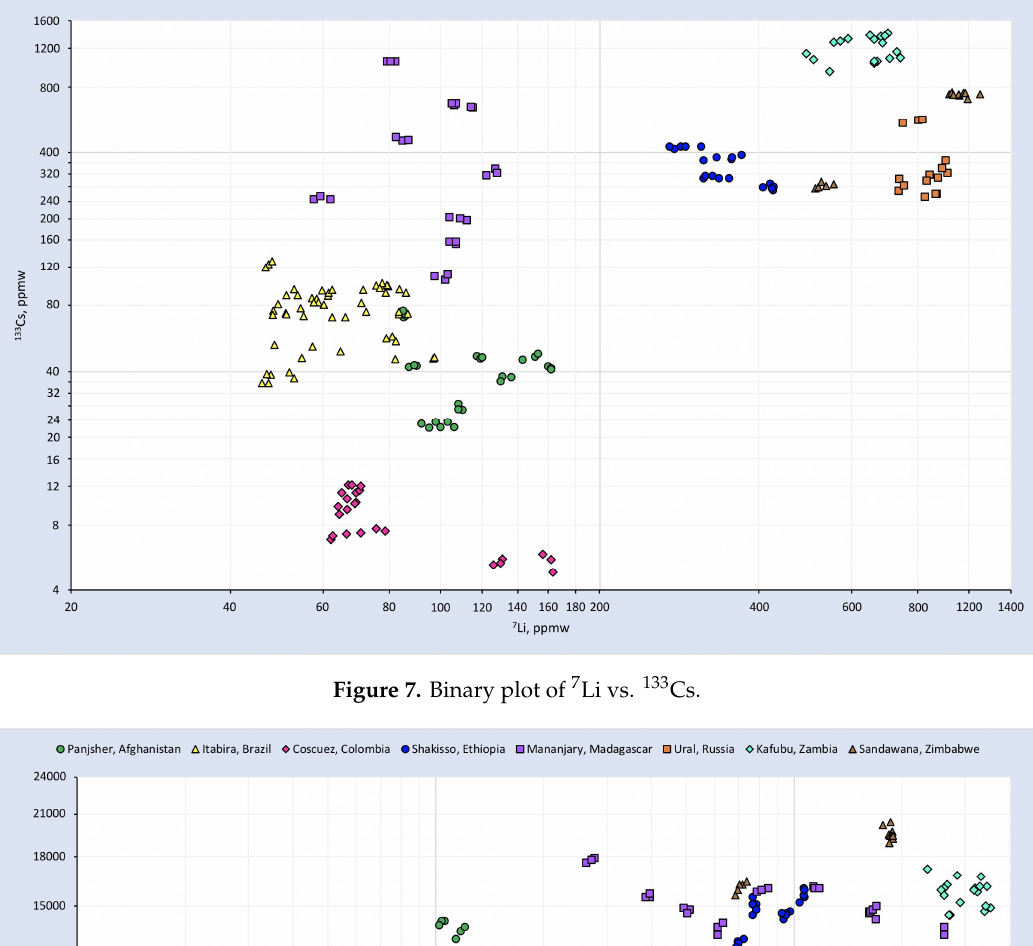
Figure 7. Binary plot of 7 Li vs. 133 Cs.